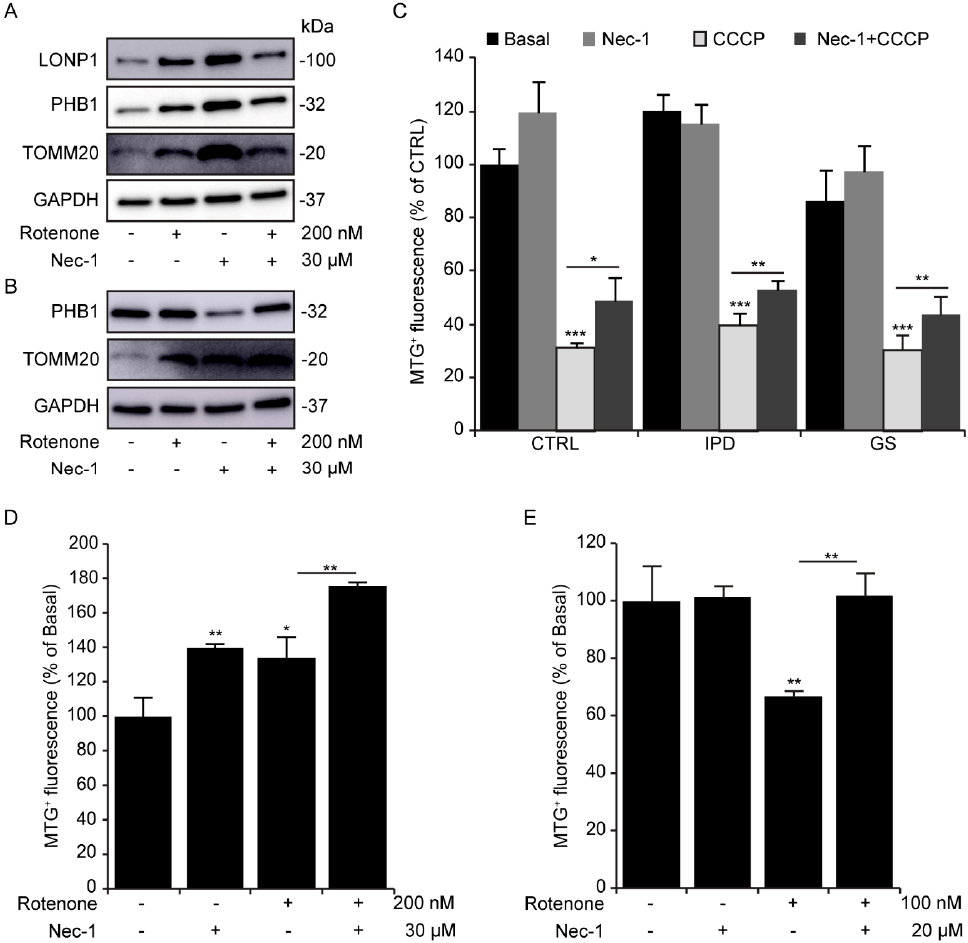
Figure 5. Necrostatin-1 increases the mitochondrial mass. ( A , B ) Human fibroblasts were treated with rotenone and / or necrostatin-1 (Nec-1) for 4 and 24 h. ( A ) The expression levels of LONP1, PHB1, and TOMM20 in human fibroblasts (HFs) after 4 h of treatment, ( B ) the expression levels of PHB1 and TOMM20 in HFs after 24 h of treatment. GAPDH is the loading control. ( C ) Human fibroblasts were treated with carbonyl cyanide 3-chlorophenylhydrazone (CCCP) and / or necrostatin-1 (Nec-1) for 24 h. Cells were loaded with 100nM of MTG.The resultsrepresentthe percentage ± SD ofMitoTracker ® Green(MTG + ) cellsdetected by flow cytometry (* p < 0.05, ** p < 0.01, *** p < 0.001), n = 10,000 events. ( D ) Fibroblasts and ( E ) SH-SY5Y cells were treated with rotenone and / or necrostatin-1 (Nec-1) for 24 h and then loaded with 100 nM of MTG. The results represent the percentage ± SD of MTG + cells detected by flow cytometry (** p < 0.01), n = 10,000 events. All experiments were done at least three